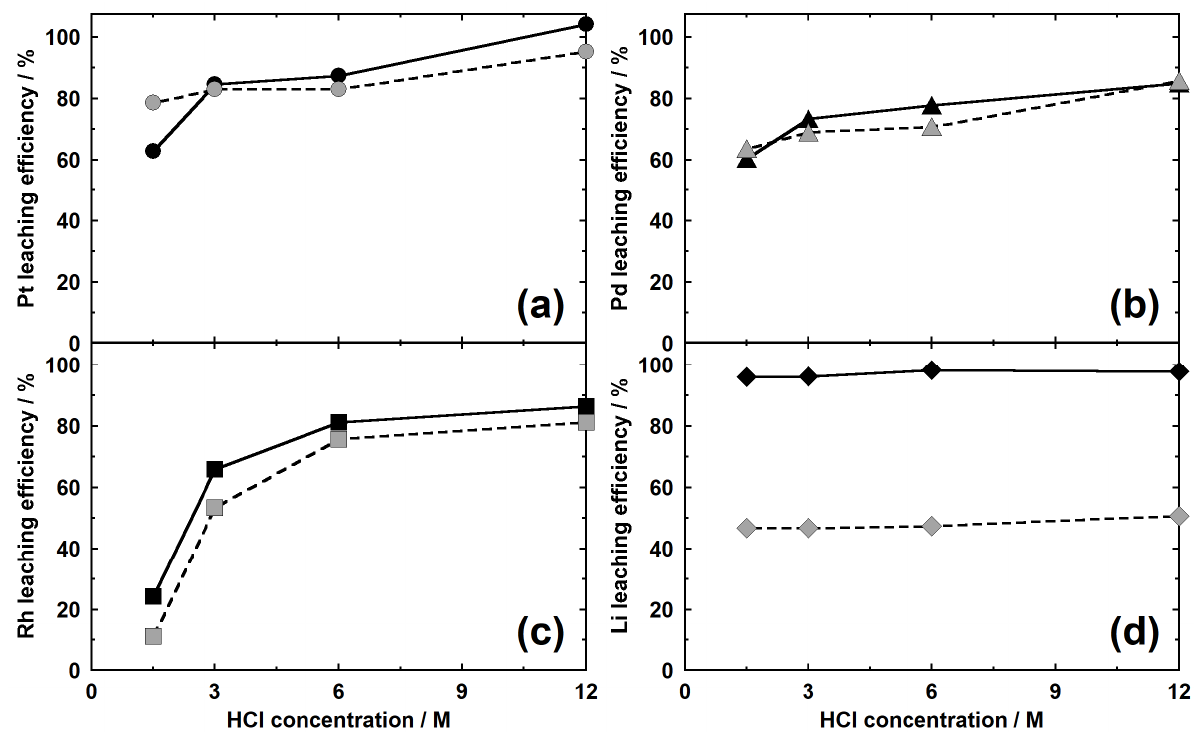
Figure 9. Metal leaching efficiencies of the samples obtained under conditions I-C-1 and I-C-5. ( a ) Pt, ( b ) Pd, ( c ) Rh, and ( d ) Li. Solid lines: condition I-C-1, dashed lines: condition I-C-5.